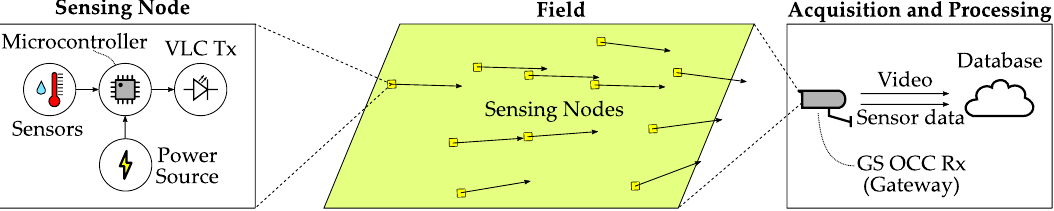
Figure 3. Proposal of the OCC equipment for Wireless Sensor